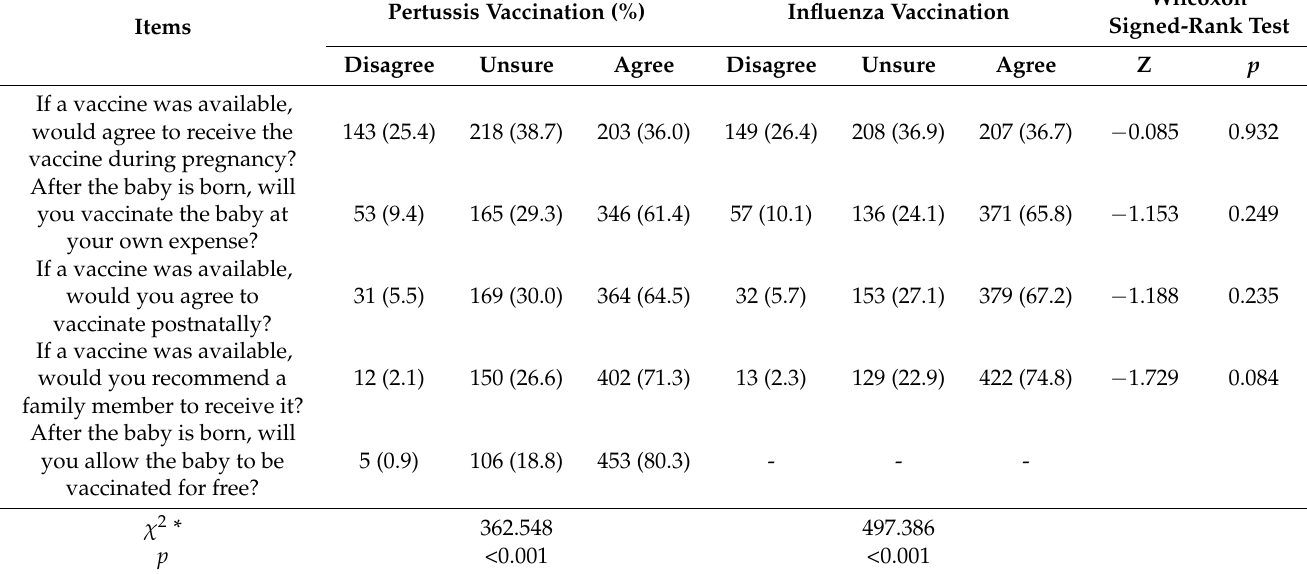
Table 3. Attitudes of pregnant women toward pertussis and influenza vaccination in different life stages and contexts.